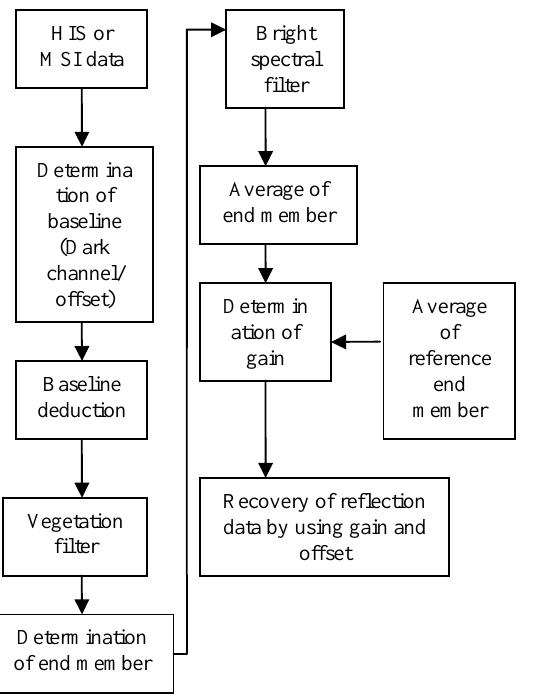
Figure 1(c: ITT Visual Information Solutions (ITT VIS), “ENVI User’s Guide, Version 4.8”).